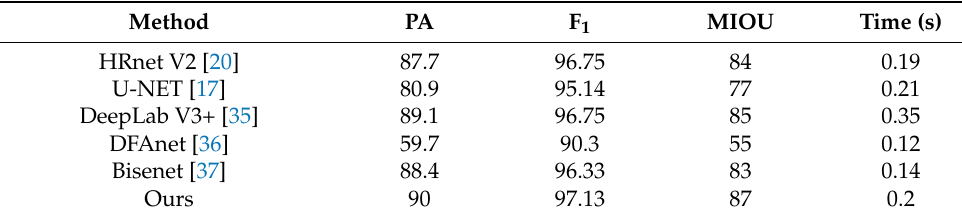
Table 1. Quantitative comparisons of models in the source